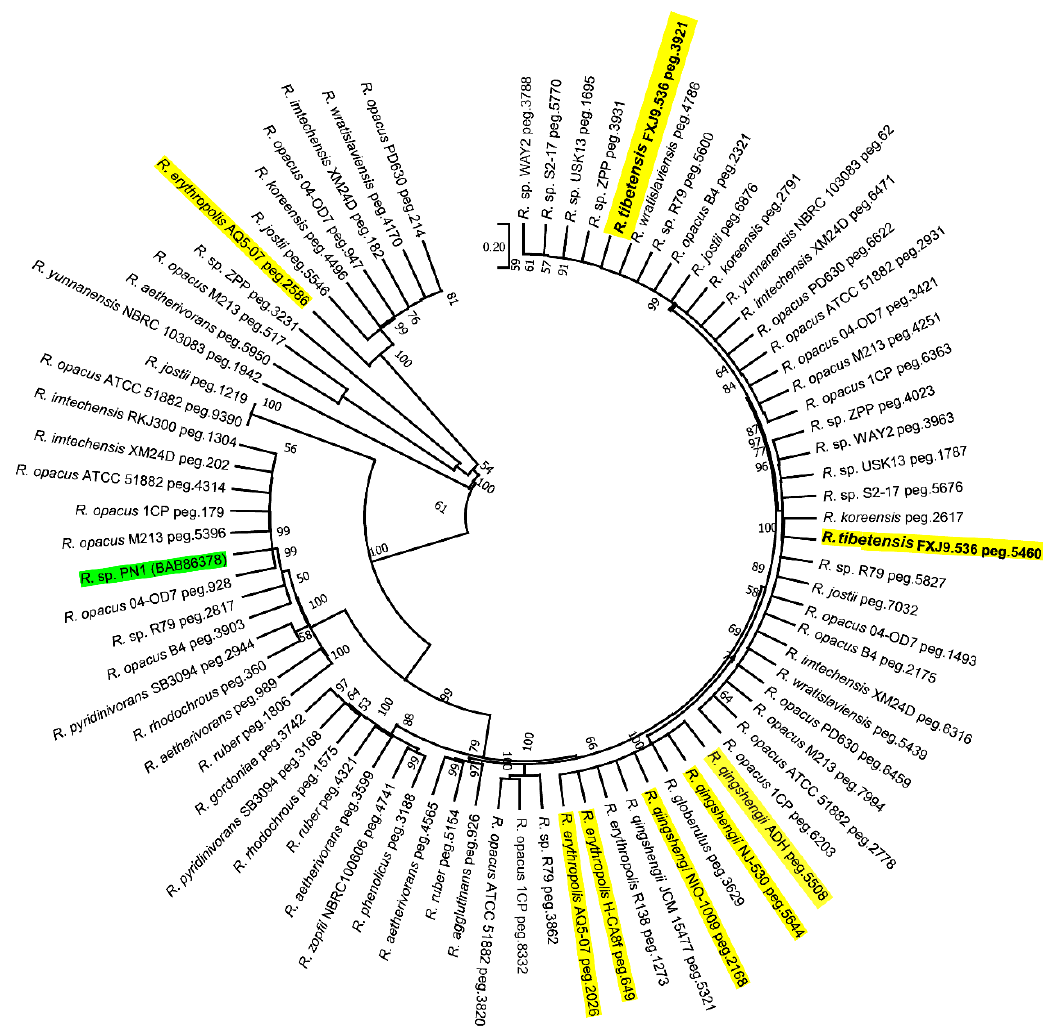
Figure 4. Maximum-likelihood phylogenetic tree based on amino acid sequences of the putative 4-hydroxyphenylacetate 3-monooxygenase genes in Rhodococcus . Sequences from cold environments and Rhodococcus sp. PN1 (4-NP hydroxylase component A) was highlighted in yellow and green, respectively. Only bootstrap values above 50% are given. Bar, 0.20 substitutions per site.